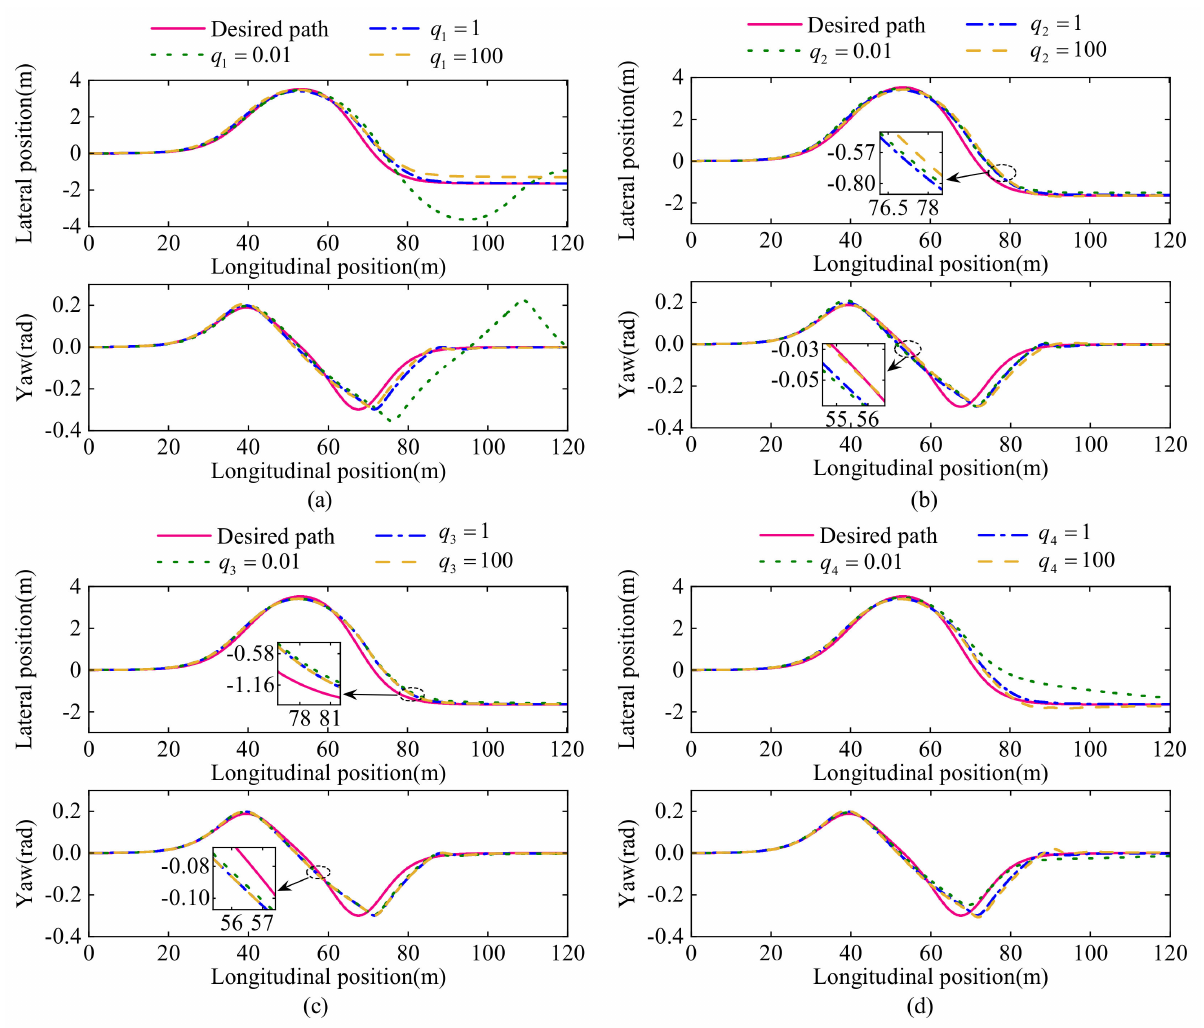
Figure 7. Response of the lateral position and yaw under different weight coefficients of q 1 , q 2 , q 3 , q 4 :